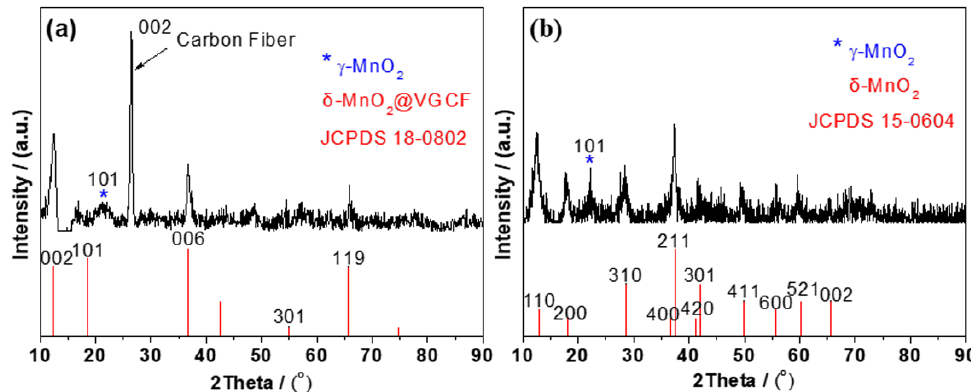
Figure 2. XRD patterns of the MnO 2 @VGCF composites ( a ) and the MnO 2 nanorods ( b ).